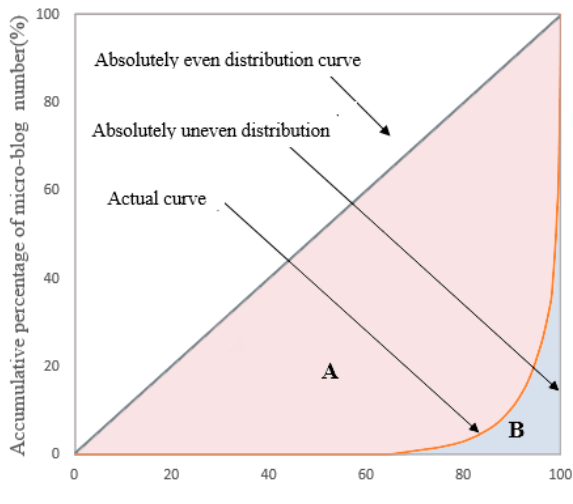
Figure 1. The degree of aggregation